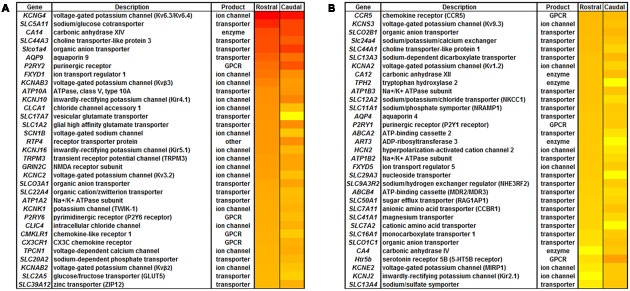
All plasma membrane-associated genes that were upregulated with increasing age in 5-HT neuron-enriched cell pools. Plasma Membrane molecules identified in IPA were significantly increased (q < 0.01) with increasing age in 5-HT neuron-enriched cell pools by FACS. (A) Gene name, description, protein type and relative change in expression (greatest increase (red) to smallest increase (yellow) for log fold-change with increasing age) is shown for identified plasma membrane-associated molecules. (B) Representation of the type of plasma membrane molecules categorized by transporters, ion channel, G-protein coupled receptors (GPCR), enzymes, or other.